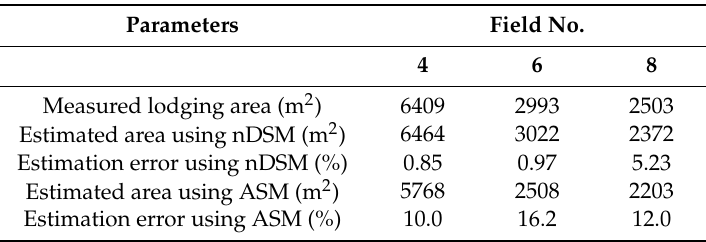
Table 3. The measured and estimated lodging areas and the resulting estimation errors using the nDSM method and the ASM textural feature.